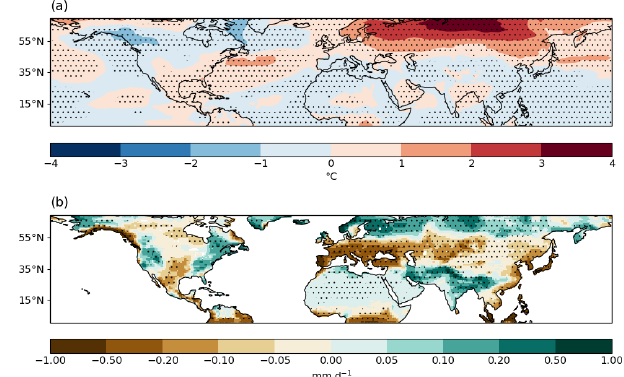
Figure 5. Multi-model mean difference in 2081–2100 December to February near-surface air temperature ( ◦ C, a ) and land precipitation rate (mmd − 1 , b ) between G6sulfur and ssp245. Areas where the difference is significant at the 5% level in a two-tailed t test are